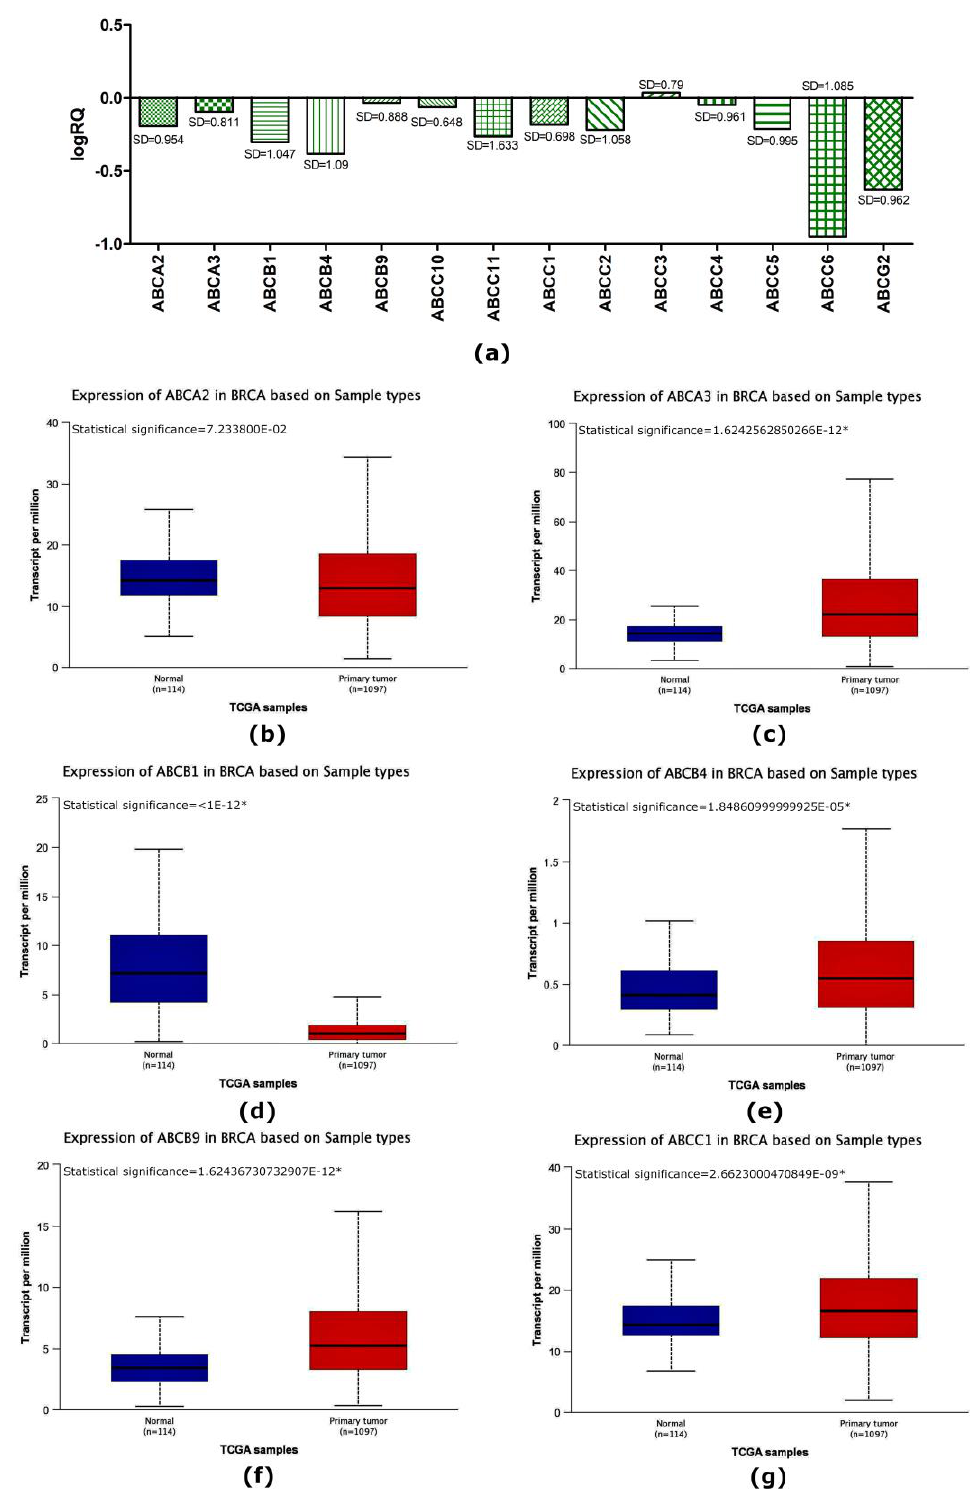
Figure 1. The average expression level of selected genes from the ABC family in patients with triple-negative breast cancer determined experimentally ( a ) and comparison of the expression level of the ABCA2 ( b ), ABCA3 ( c ), ABCB1 ( d ), ABCB4 ( e ), ABCB9 ( f ), and ABCC1 ( g ) genes in breast cancer patients compared to normal tissue obtained from the TCGA database using the Ualcan web tool. Statistically significant values are marked with